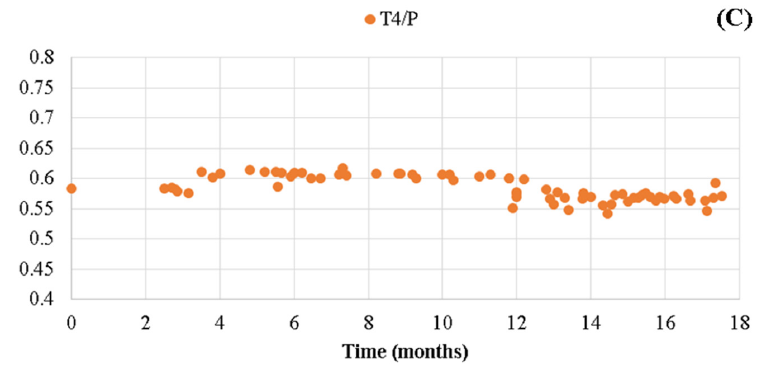
Figure 5. Evolution of crocin isomers, expressed as % of total crocins ( A ); trans / cis ratio ( B ) and trans-4 GG/Picrocrocin (T4/P) ratio ( C ) during storage under controlled conditions (25 °C ± 2 °C, 60% HR ± 5%).